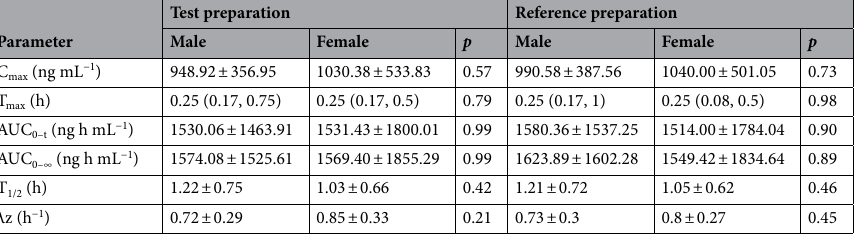
Table 4. The PK of test and reference preparation in males (N = 24) and females (N = 16) healthy volunteers. C max maximum blood concentration, T max time to maximum blood concentration, AUC 0–t AUC from time 0 (baseline) to time t, AUC 0–∞ AUC from zero to infinity, T 1/2 elimination half-life, λz apparent end elimination rate constant. Data was presented in mean ± standard deviation. p > 0.05, not